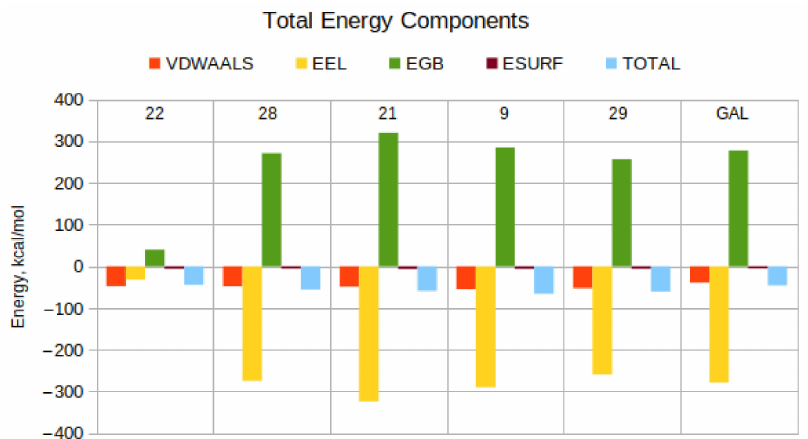
Figure 3. Total energy components of each ligand complexed with AChE. The positive control is GAL. The van der Waals and electrostatic interaction energies are denoted as VDWAALS and EEL, respectively. The polar and non-polar solvation energies are denoted as EGB and ESURF, correspondingly. The total energy of binding is denoted as